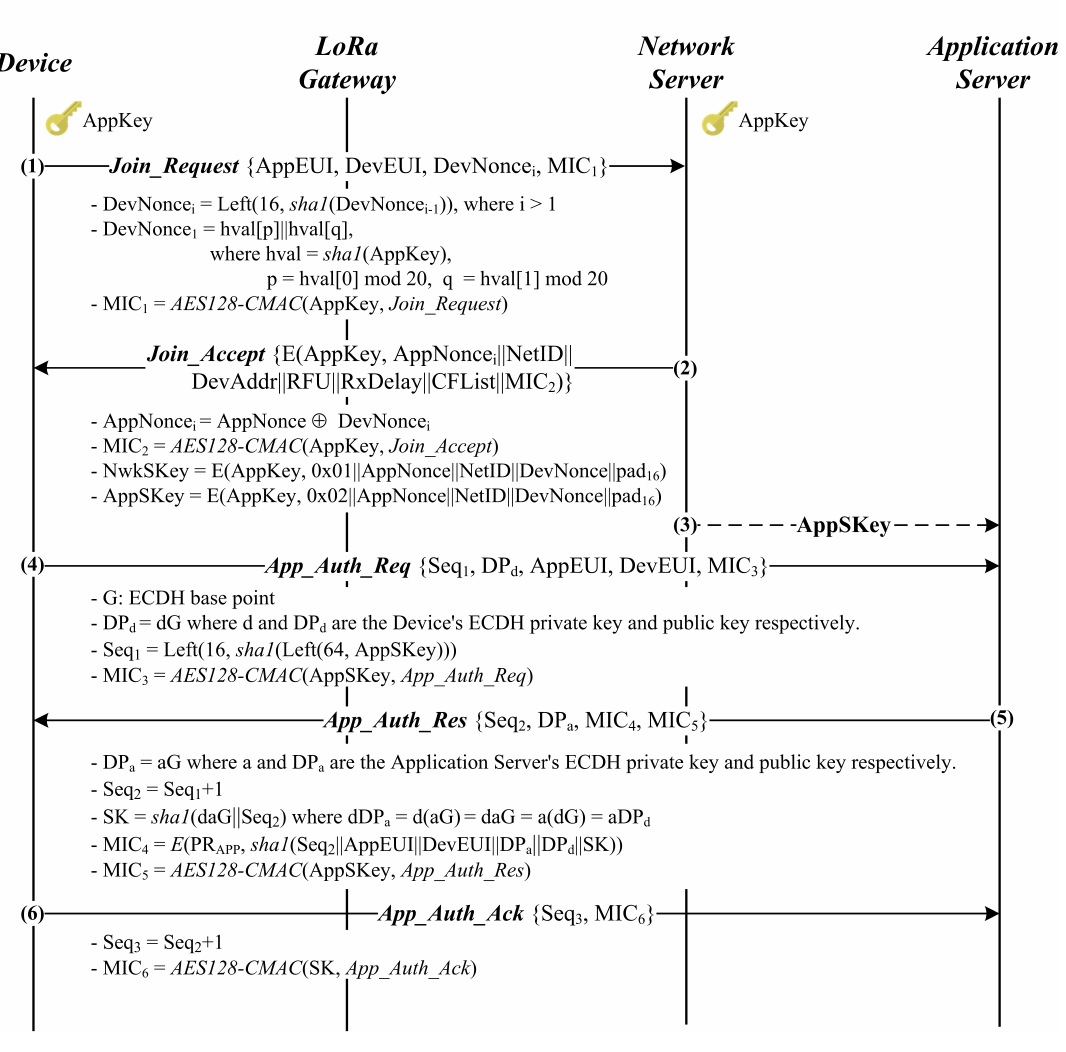
Figure 3. Proposed protocol’s default option.